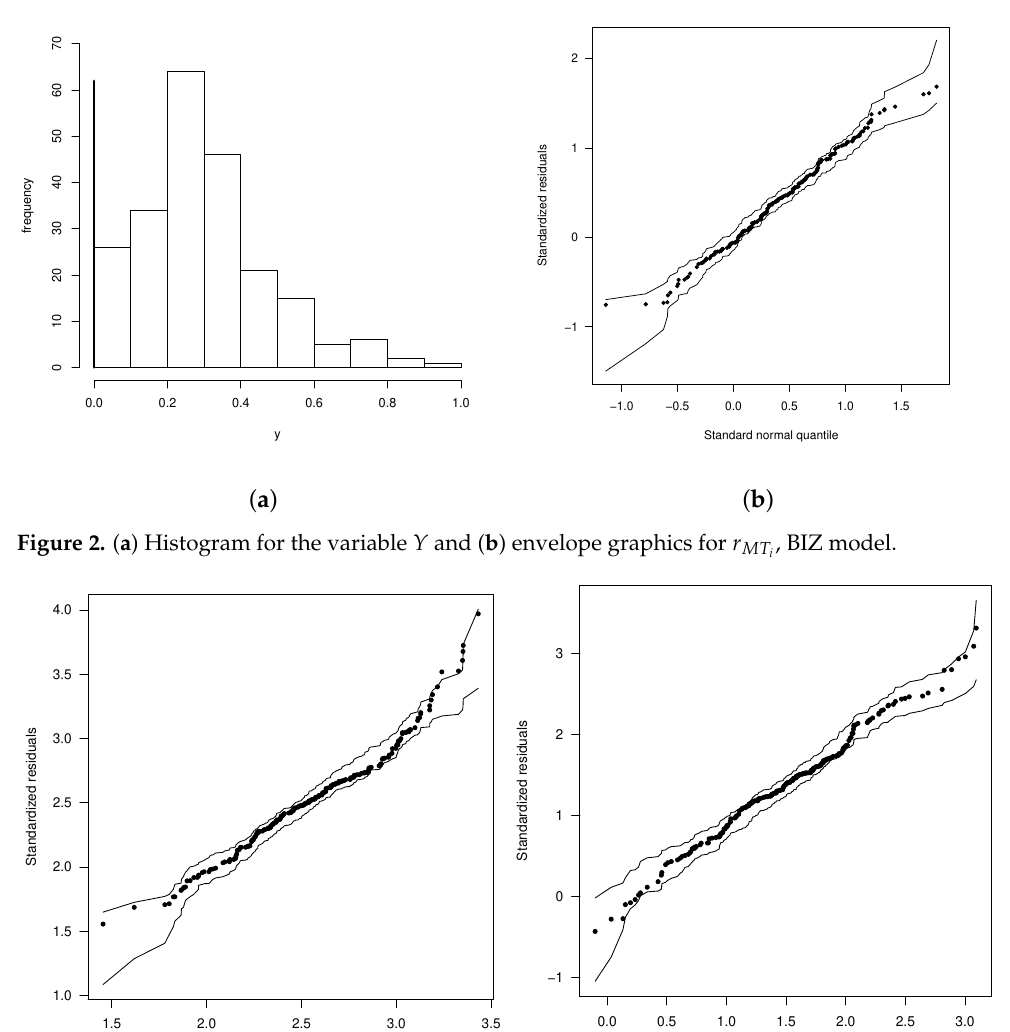
, ( a ) GCPSN-logit model, and ( b ) PSNIZ-logit i